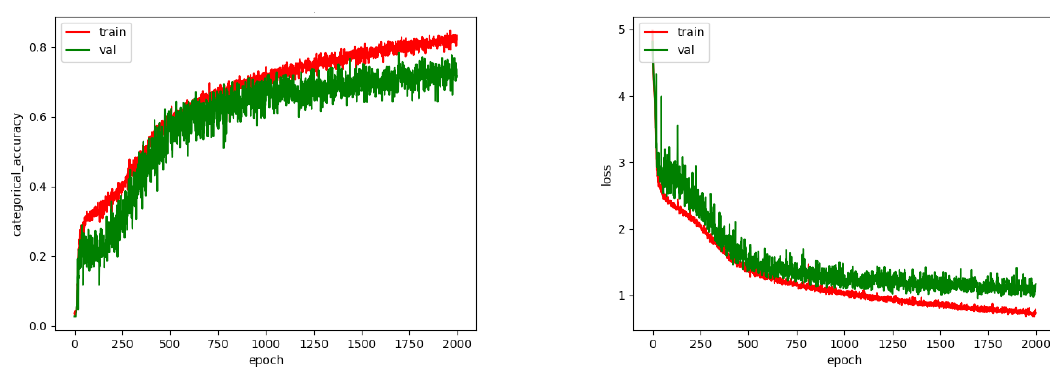
Figure 10. Accuracy and loss for CNN.